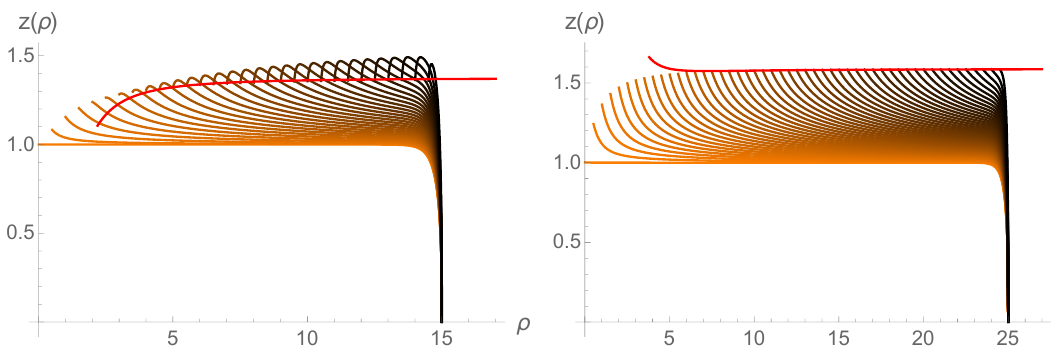
Figure 4. Extremal surfaces in the d = 3 Schwarzschild geometry. Left: in the Vaidya setup we show the portion of the extremal surfaces that are in the black brane region for R = 15. Earlier times are drawn by darker colors. The red line shows (4.20), which is an expansion for z c for large (cid:26) c . Right: in the end of the world brane setup we chose R = 25, and the red line is